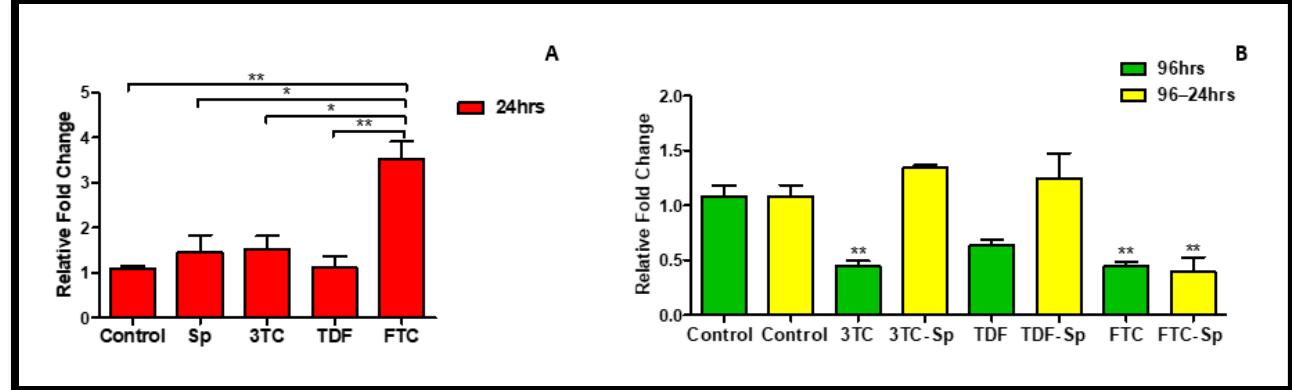
Figure 4. Effects of SP and HAART (3TC, TDF, and FTC) on NRF-2 mRNA levels. NRF-2 mRNA levels after exposure of HepG2 cells to ( A ): SP and HAART for 24 h, ( B ): HAART (96 h), and HAART (96 h) followed by SP (24 h); * p < 0.05, ** p < 0.005 .